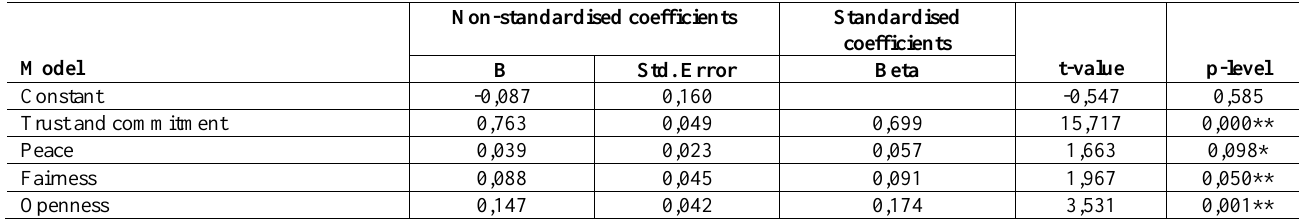
Table 3: Multiple regression results: Impact of the business values Trust and commitment , Peace , Fairness and Openness on the dependent variable Harmonious family relationships